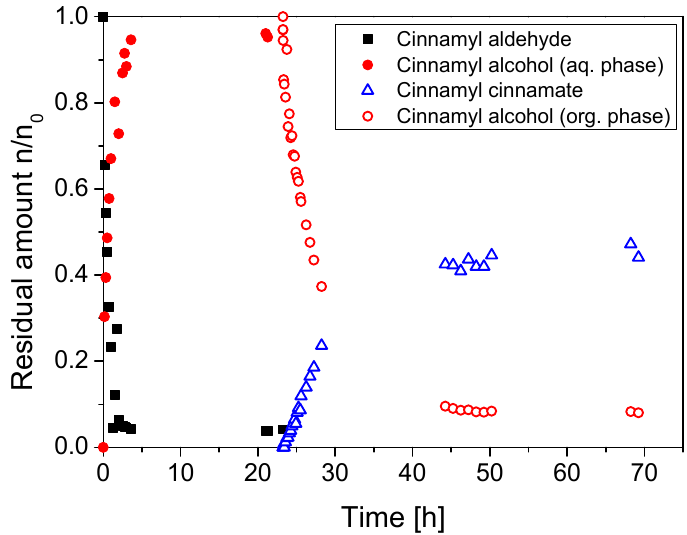
Figure 5. Lab-scale application of the cascade reaction. Conditions: aqueous phase: potassium phosphate buffer pH 8, 0.1 M, V = 25 mL, c Aldehyde = 4 mM, c NADH = 1 mM, m ADH = 2 mg, m FDH = 5 mg, c sodium formate = 100 mM, 30 °C; organic phase: 25 mL xylene with extracted alcohol, c Acid = 3.4 mM, m Lipase = 1 g, 3.3 g molecular sieve, 60 °C.